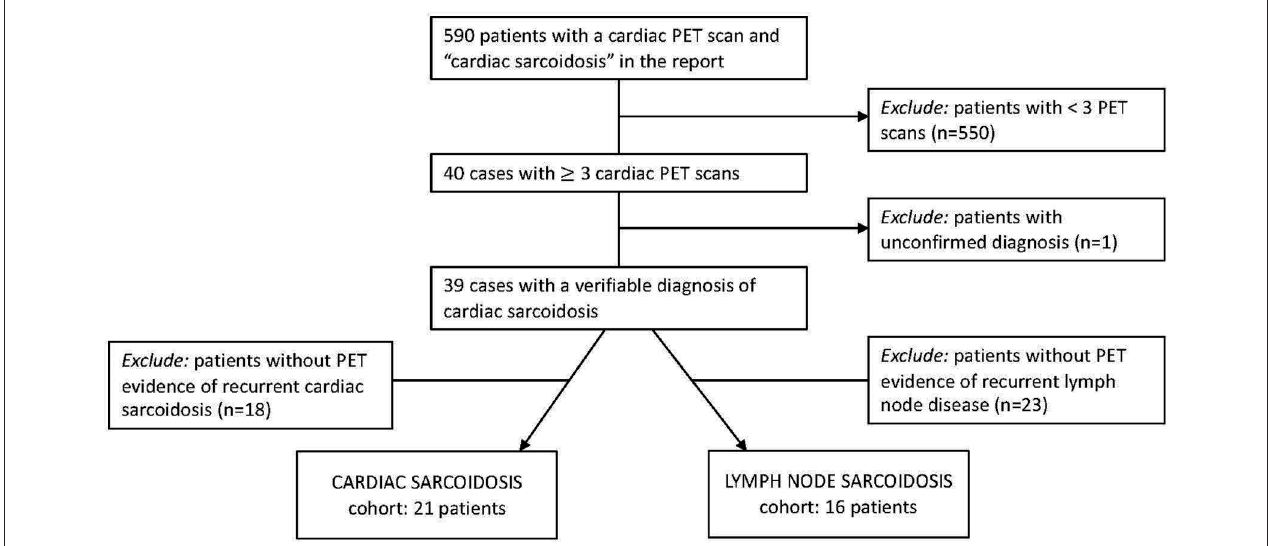
our analysis to patients with recurrent facial sarcoidosis, as this region was assessed in sub-compartment